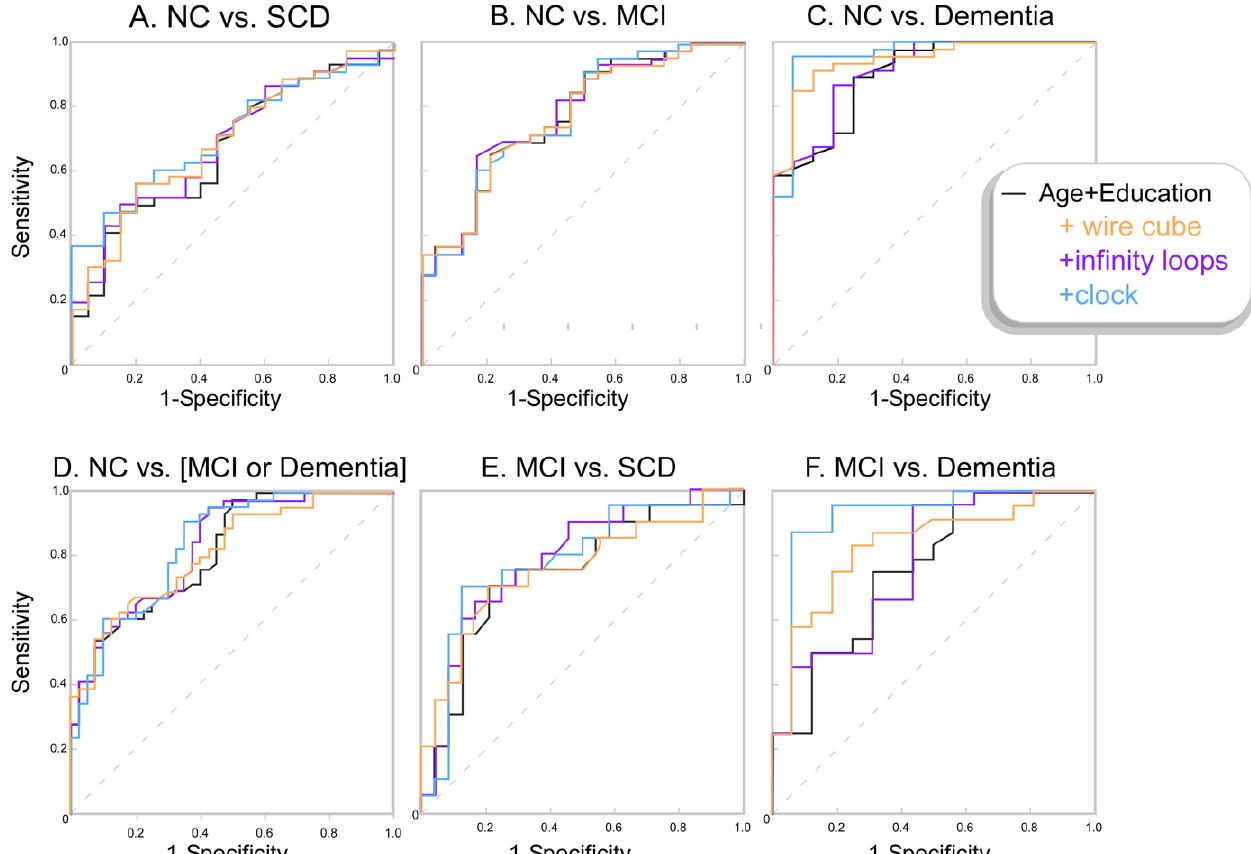
Figure 2. ROC curves showing the sensitivity and specificity of the different binomial logistic model probabilities. The model including only age and years of education is shown in black. The model with the wire cube test included (i.e., age and education and wire cube score) is shown in orange. The model with infinity loops included (age and education and infinity loops score) is shown in purple, and the model with the CDT (age & education & CDT score) is shown in blue.